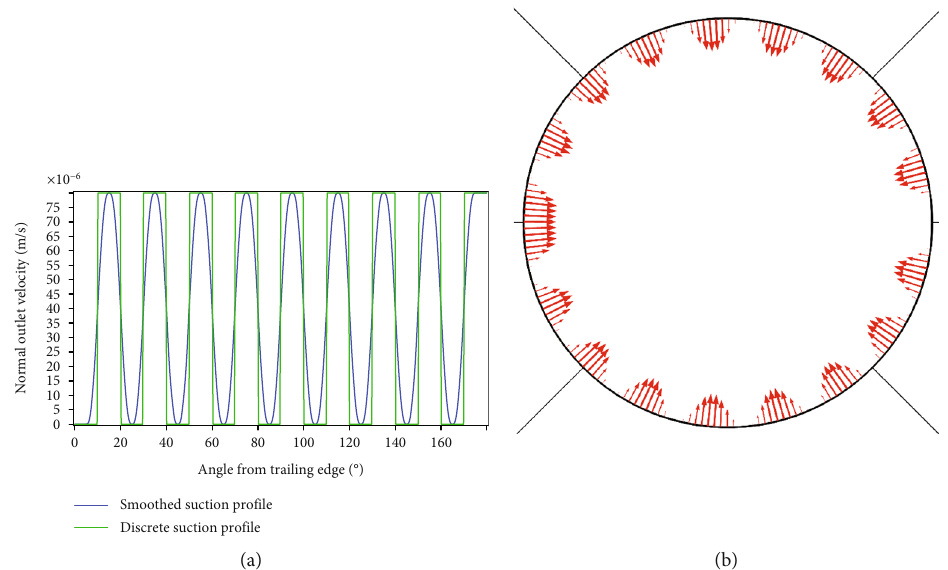
= 0 and c = 50 : (a) piecewise function and (b) arrow plot of the velocity pro fi le Q Q